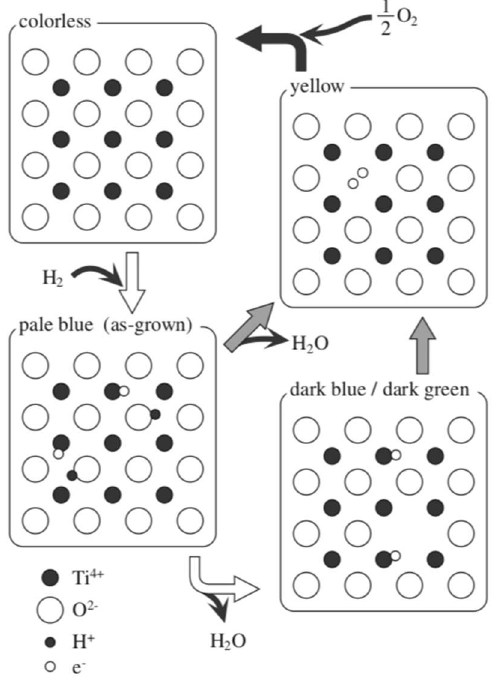
Figure 12. Schematic representation of the structural model for defect states in reduced Titania with their characteristic optical behavior and preparation methods. White, grayish and black arrows represent heat-treatments under hydrogen, inert and oxygen atmosphere, respectively. Reproduced from [127], Copyright 2004, The Physical Society of Japan.